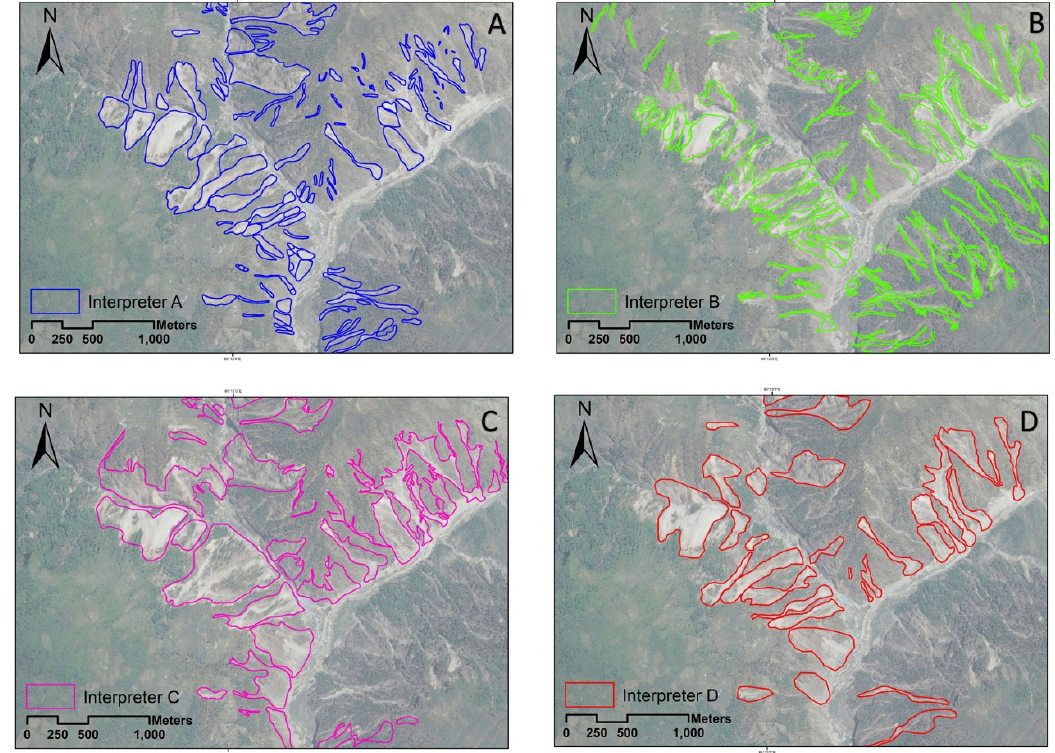
Figure 10. E ff ect of amalgamation for the same area mapped by four di ff erent people in the area near Figure 10. Effect of amalgamation for the same area mapped by four different people in the area near the Trishuli river, ( A ) Inventory A, ( B ) inventory B, ( C ) inventory C, and ( D ) inventory the Trishuli river, (A) Inventory A, (B) inventory B, (C) inventory C, and (D) inventory D.